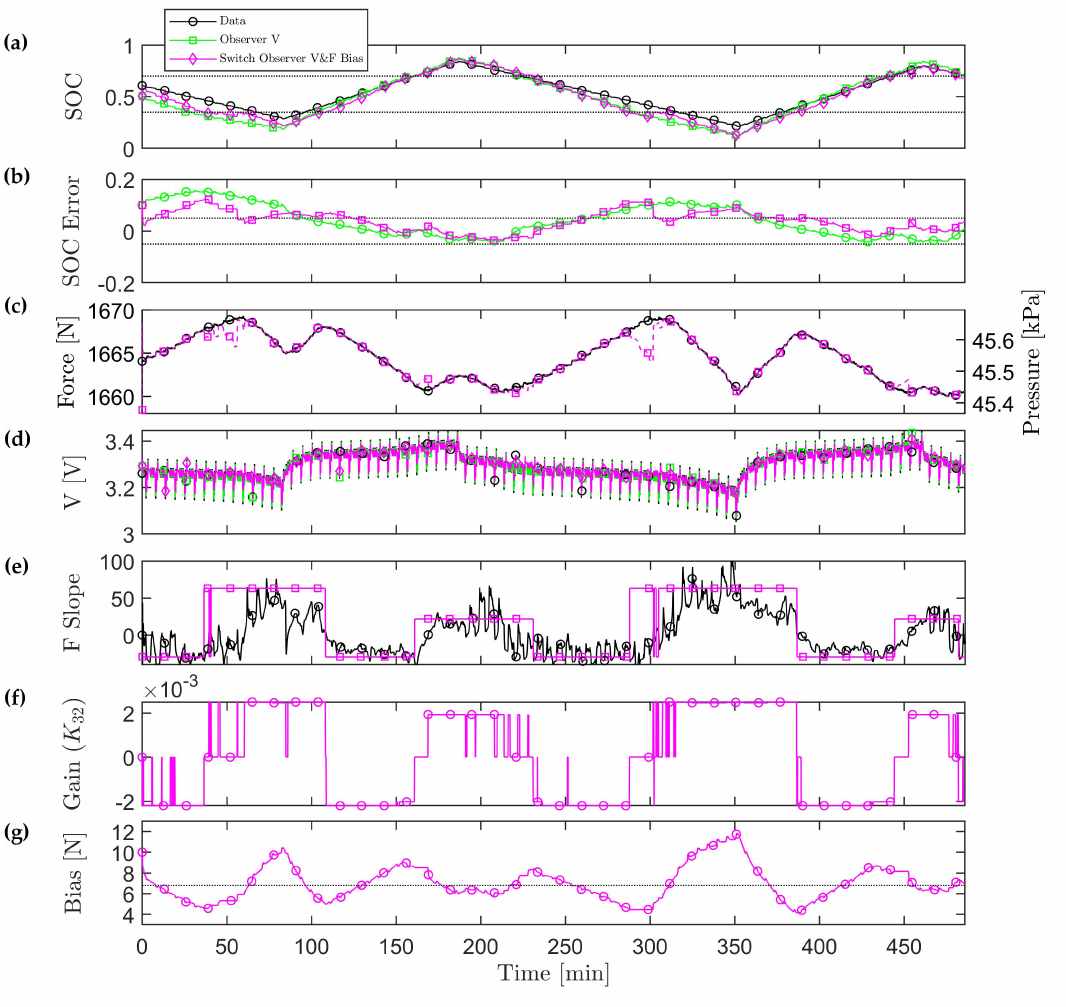
Figure 8. Experimental validation of the developed observer (Switch Observer V&F Bias) with 10% (0.1) initial SOC error. The offline experimentally measured current, voltage, and force data were fed into the model to assess performance. ( a ) Comparison of high accuracy coulomb counting based state of charge (SOC) with observer estimates. ( b ) Comparison of the state of charge (SOC) error with the dashed lines representing the target ± 5% bound. The observer with force bias state estimation demonstrates better performance. The large error at low SOC for both observers is due to model mismatch the piecewise linear OCV–SOC fit at low SOC. ( c ) Comparison of measured and estimated force. ( d ) Comparison of the experimental and observer modeled terminal voltage. ( e ) Comparison of the estimated slope d ˜ F and observer model. ( f ) Comparison of the feedback gain K 32 from force to SOC dz based on the switching logic. ( g ) The Bias state estimate fluctuates around the average value (denoted by the horizontal dashed line). This could be due model mismatch, where the force error is exciting the bias state